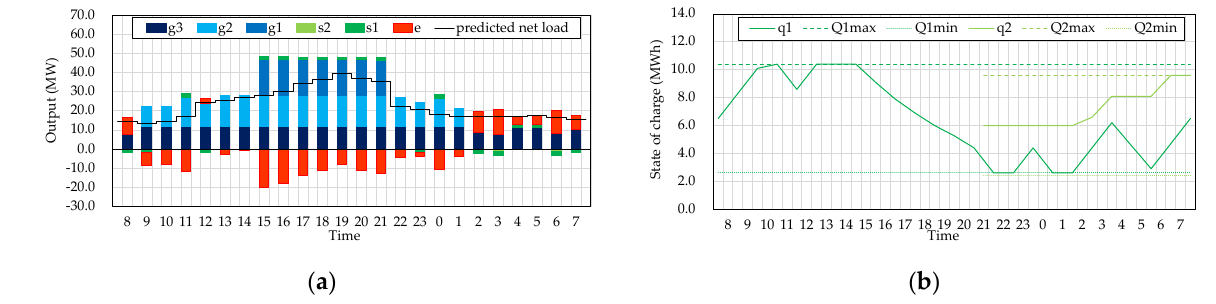
Figure 6. Optimal operation schedule on traditional framework: ( a ) Operation schedule; ( b ) Transition of SOC level.